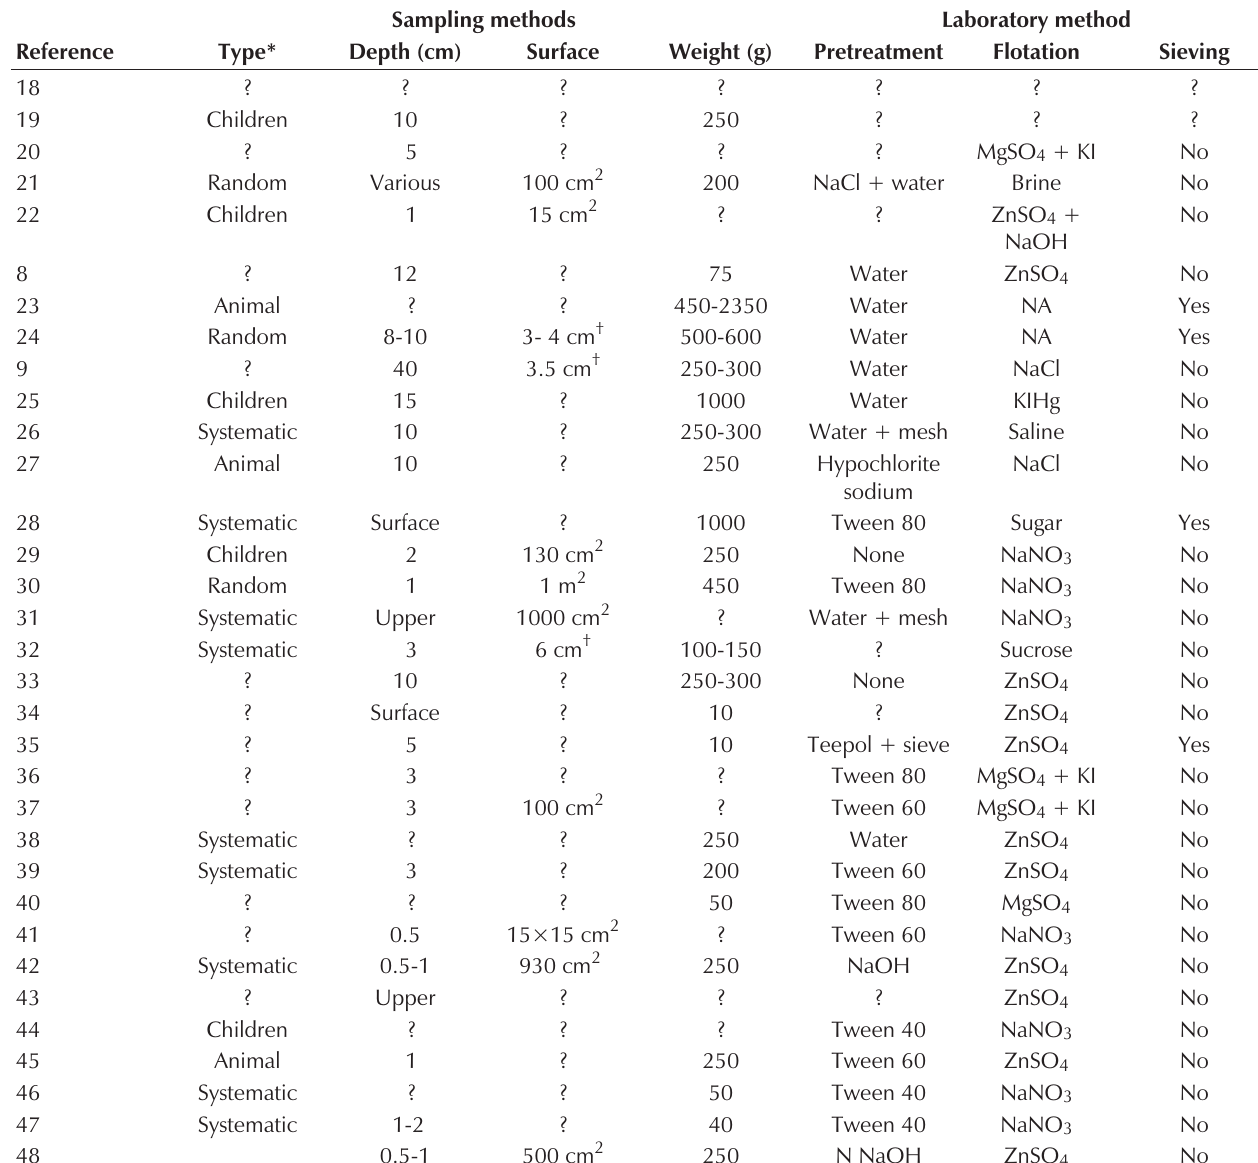
Methodologies used in the recovery of Toxocara species ova from sand and soil Sampling methods